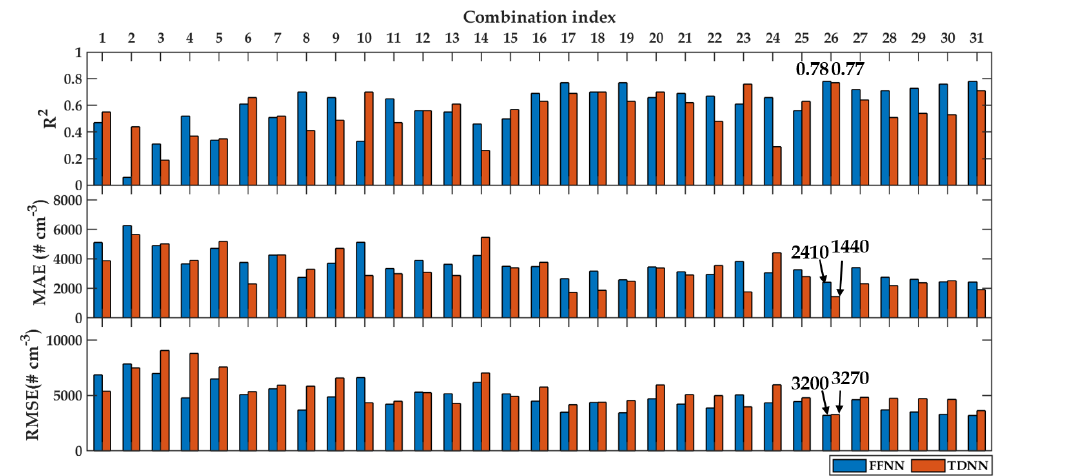
Figure 8. Performance metrics of daily modeling using FFNN (blue) and TDNN (red). The top, middle, and bottom sub-figures are R 2 , MAE, and RMSE, respectively.